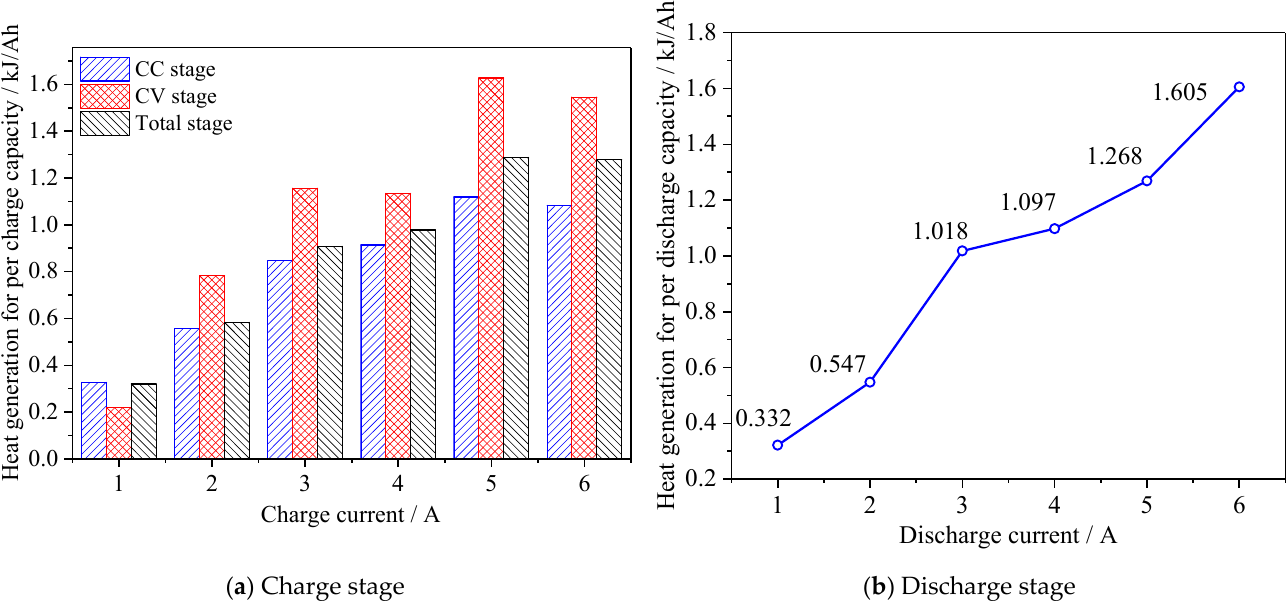
Figure 11. Heat generation of per available capacity change as operating currents increase under an isothermal environment of 25 °C.